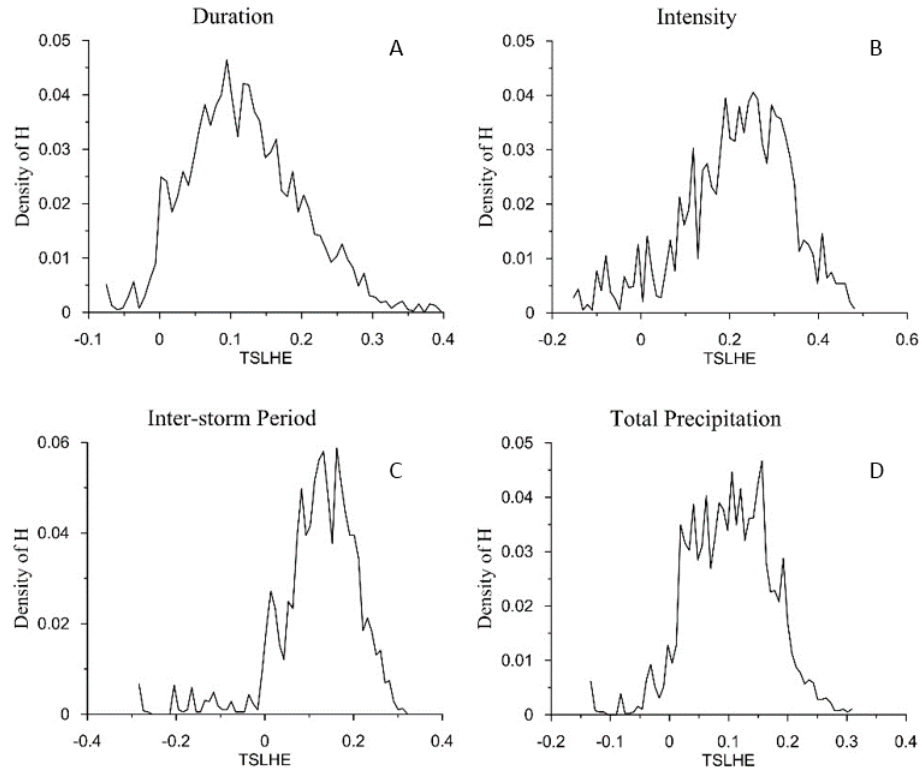
Figure 5. Probability density functions (PDF) of the time-scale local Hurst exponent (TSLHE) calculated for each of the storm properties using the full data sets with duration ( A ), intensity ( B ), inter-storm period ( C ), and total precipitation ( D ).